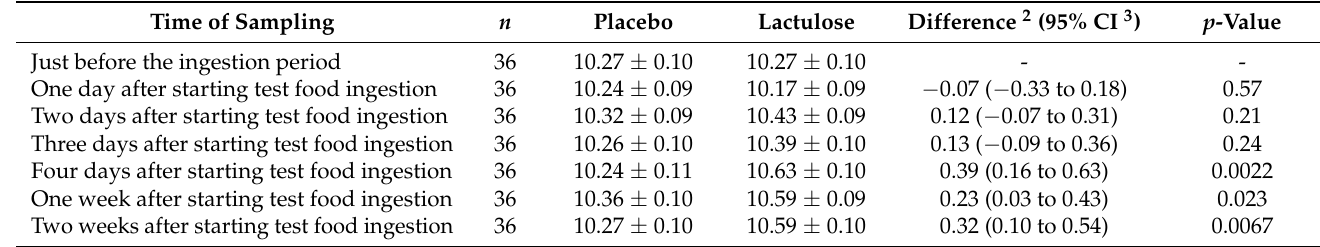
Table 5. Transition in the cell numbers of genus Bifidobacterium in the faeces 1 .